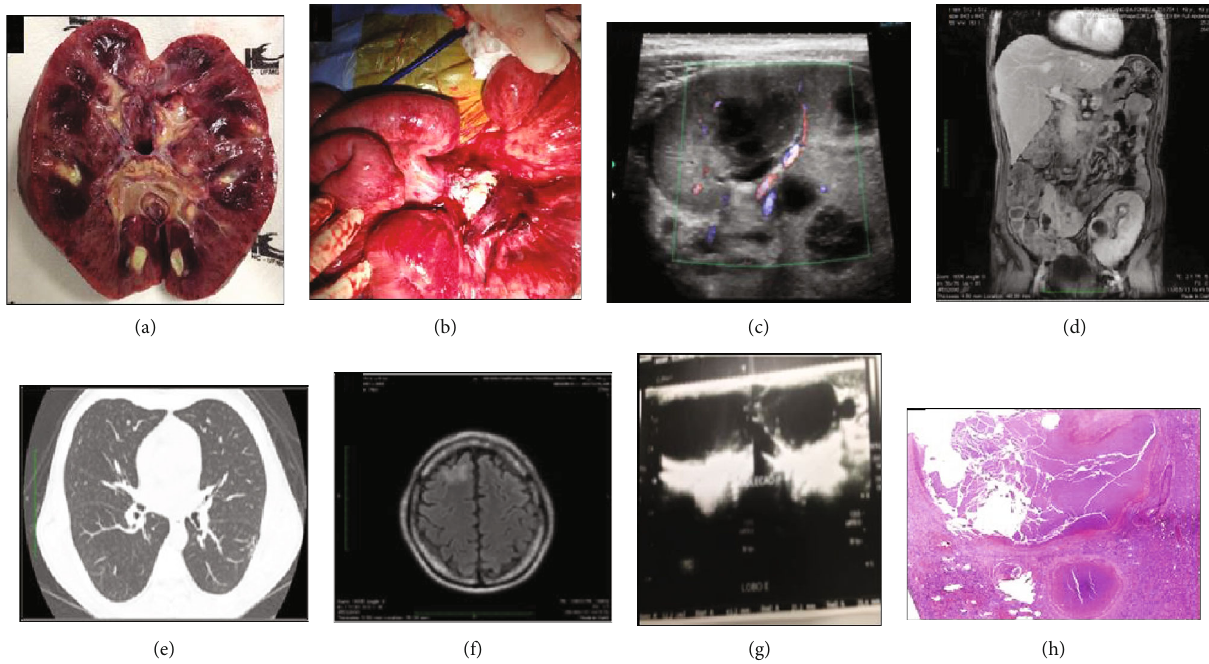
Figure 2: Images, surgical fi ndings, and histological exams of the SPK transplant recipient: (a) caseous necrosis in the explanted kidney; (b) caseous necrosis in the mesentery; (c) nodule in the renal hilum, di ff use urothelial thickening, and compression of renal vein; (d) pancreas: collection adjacent to pancreatic graft; (e) lung endobronchial spread: “ tree-in-bud ” ; (f) brain abscess: frontal lesion with perilesional halo of edema; (g) thyroid: increased volume, heterogeneous collection on the left lobe; (h) caseating granuloma in renal